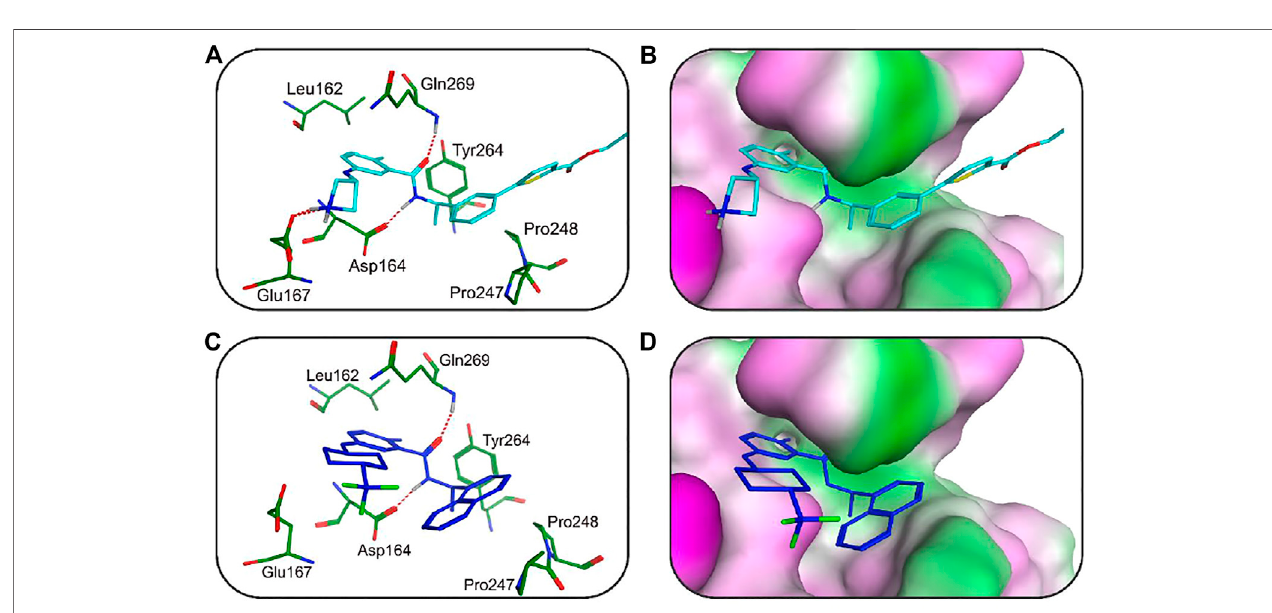
FIGURE9|(A) The3Dligand – proteininteractiondiagramforthebindingsiteoftheSARSCoV-2PLprowithhit2.Theactive-siteresiduesareshowningreenstick form. Hit 2 is color-coded by cyan. The hydrogen-bond network with protein residues is represented by dotted lines. (B) Closeup stereo view of the structure of the PLpro-hit 2 complex. (C) The 3D ligand – protein interaction diagram for the binding site of the SARS CoV-2 PLpro with hit 4. Hit 4 is color-coded blue. The active-site residues are shown in green stick form. The hydrogen-bond interaction is represented in dotted lines. (D) Closeup stereo view of the structure of the PLpro-hit 4